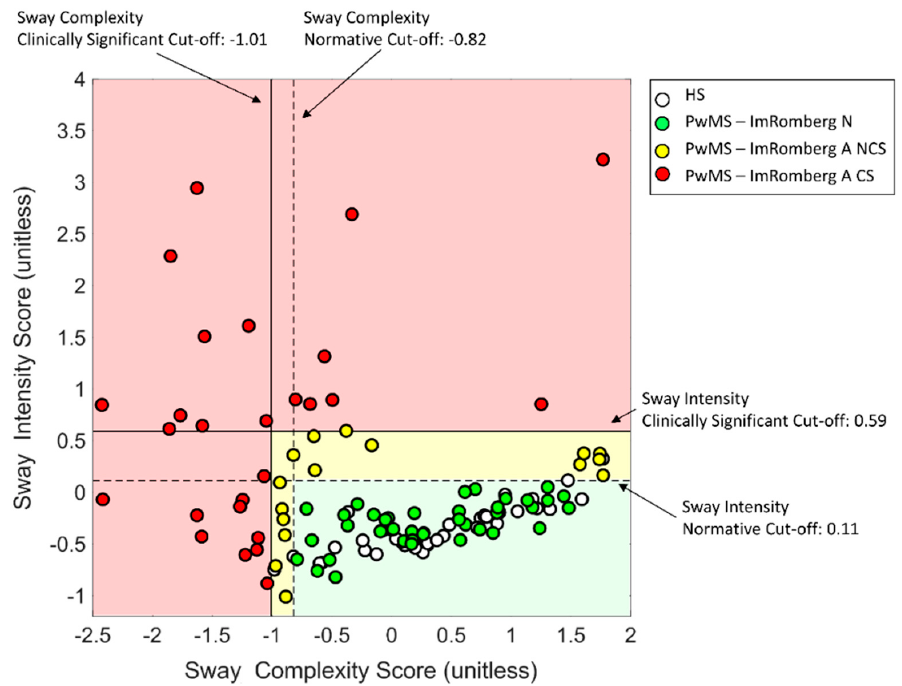
Figure 2. Scatterplot reporting sway complexity and sway intensity scores extracted from the Im-